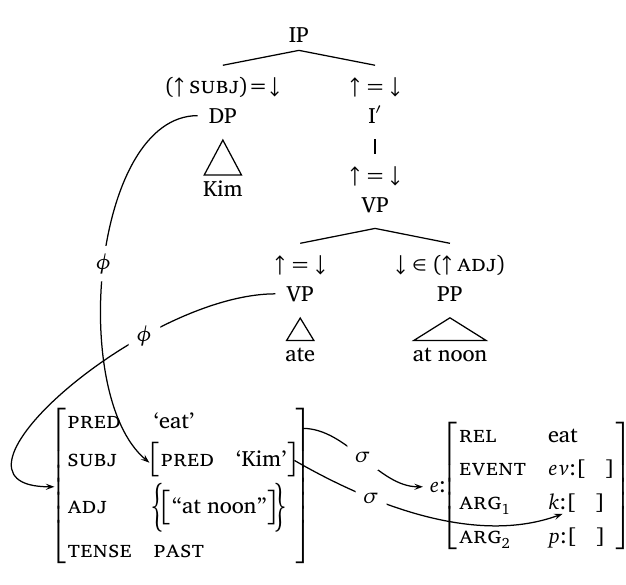
Alternative analysis